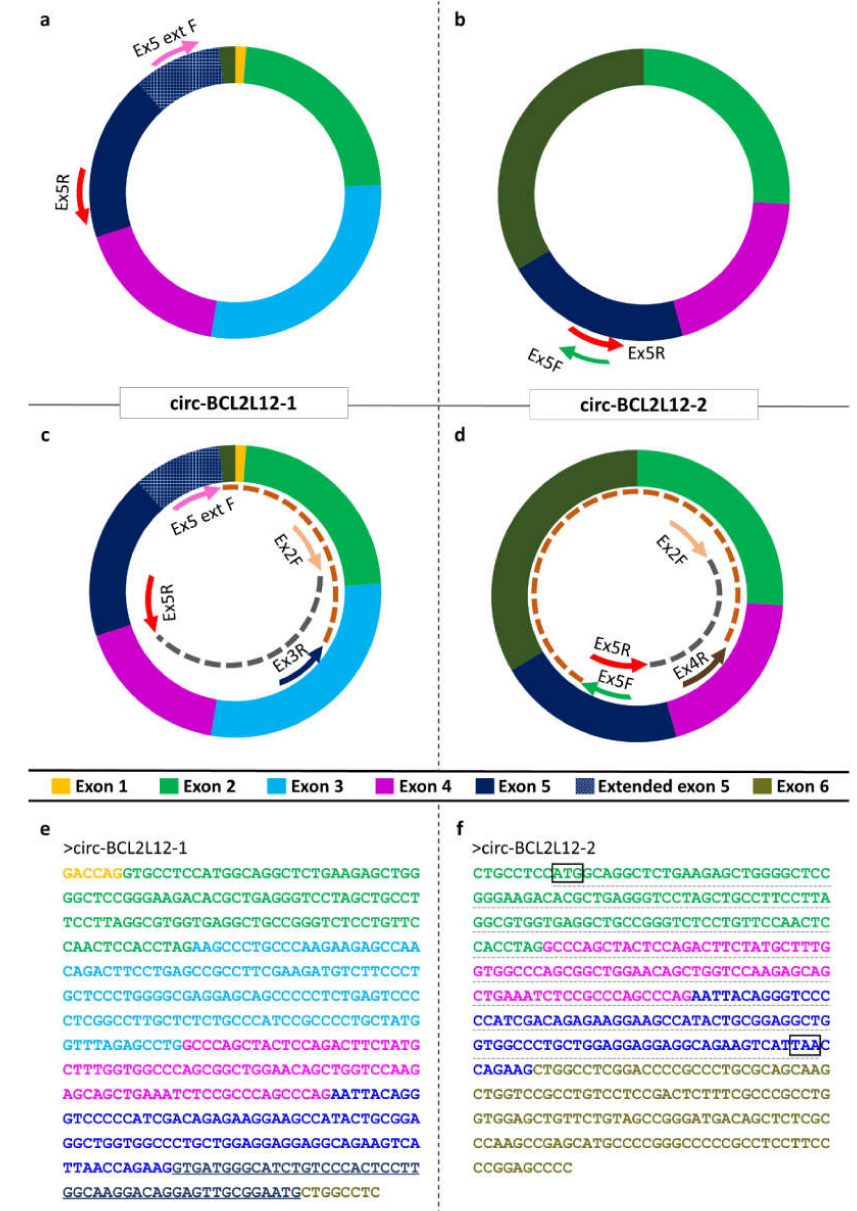
Figure 1. The structure and sequences of BCL2L12 circular RNAs (circRNAs). ( a , b ) Arrows outside the circles show the annealing positions of the primers used in the first-round PCR assay. ( c , d ) Arrows inside the circles indicate the annealing positions of the primers used in the semi-nested PCR assays, while arcs indicate the respective amplicons. ( e , f ) The sequences of BCL2L12 circRNAs, starting from the back-splice site. The colored fonts of the exon sequences match the colors used in the graphical illustrations of the circRNA exon structures. The black boxes show the putative translation start and stop codons of the predicted open reading frame (ORF). The ORF is underlined with a grey dashed